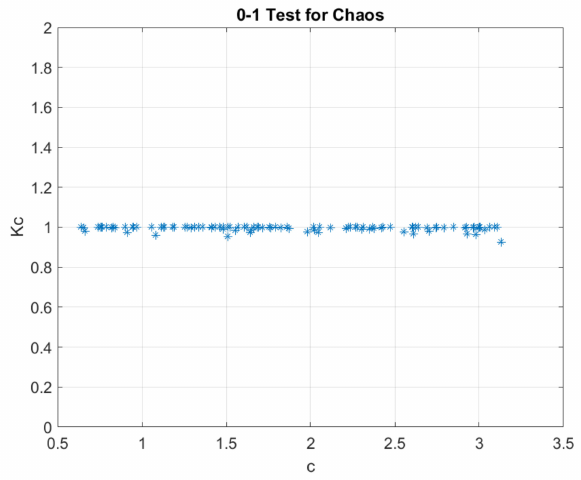
Figure 2. Result of the 0–1 test for chaos of the sound signal under